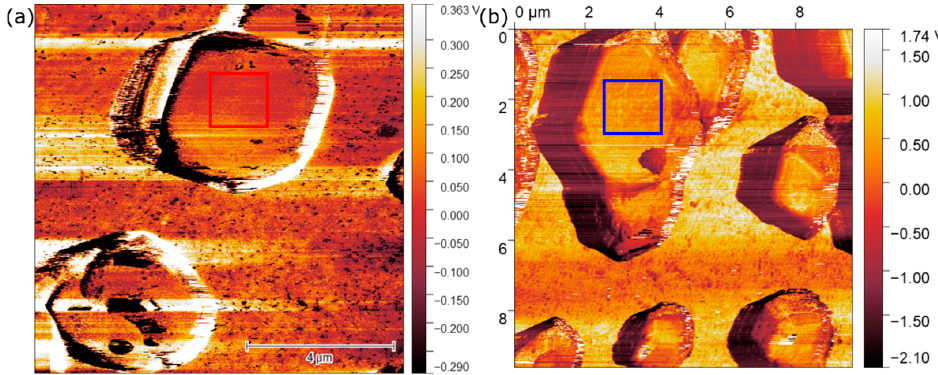
Figure 9. KPFM images for (a) (100) and (b) (110) facets from CU, respectively RD particles. From the red and blue marked area an average CPD of 0.389 V for (100) and 0.349 V for (110) is determined. The amplitude images are added in Figure S10.